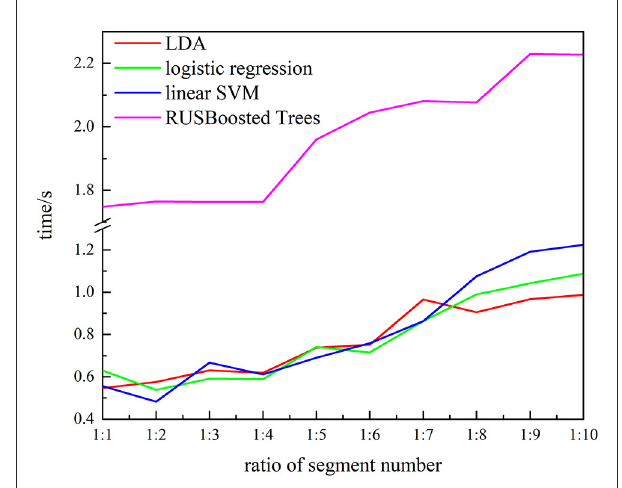
FIGURE13 Relationship between the execution time and ratio of segment numbers for subject 1 (the number of k-complex is fixed as 263,